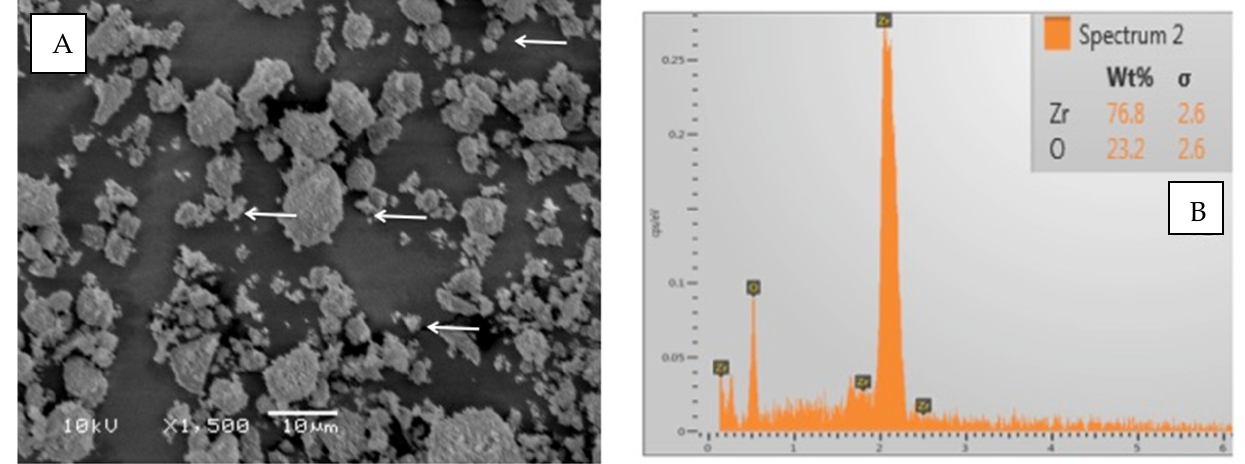
Figure 4. ( A ) SEM image of Zirconia oxide particles (ZrO 2 ). The particles had an irregular shape. The particle size was 500 to 700 nm (arrows denote small particles). ( B ) The EDX analysis showed dominant presence of Zr with a small quantity of O in the tested powder.